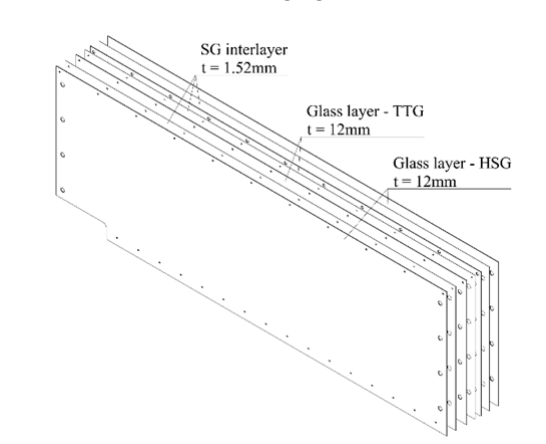
Fig. 4 Exploded view of the vertical laminated glass slab.